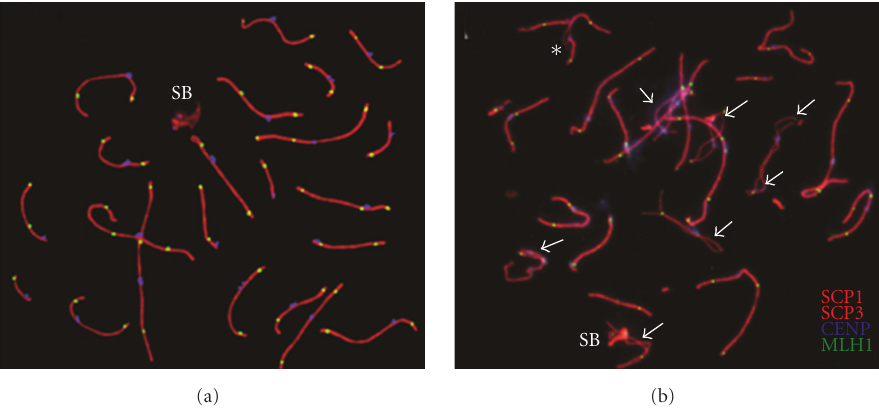
Figure 3: Immunolabeled pachytene cells with synaptonemal complexes. (a) Representative image from the control group showing the normal morphology of the synaptonemal complex and sex body (SB). (b) Representative image of the cytological analysis of the patient’s cells. Arrowheads indicate multiple asynaptic regions in the autosomal synaptonemal complex; an asterisk indicates a loop of asynapsis as a consequence of pericentromeric heterochromatin polymorphism of chromosome 9. SCP1 and SCP3 indicate synaptonemal complexes in red; CENP indicates centromere in blue, and MLH1 (mut L homolog 1) indicates recombination foci in green.